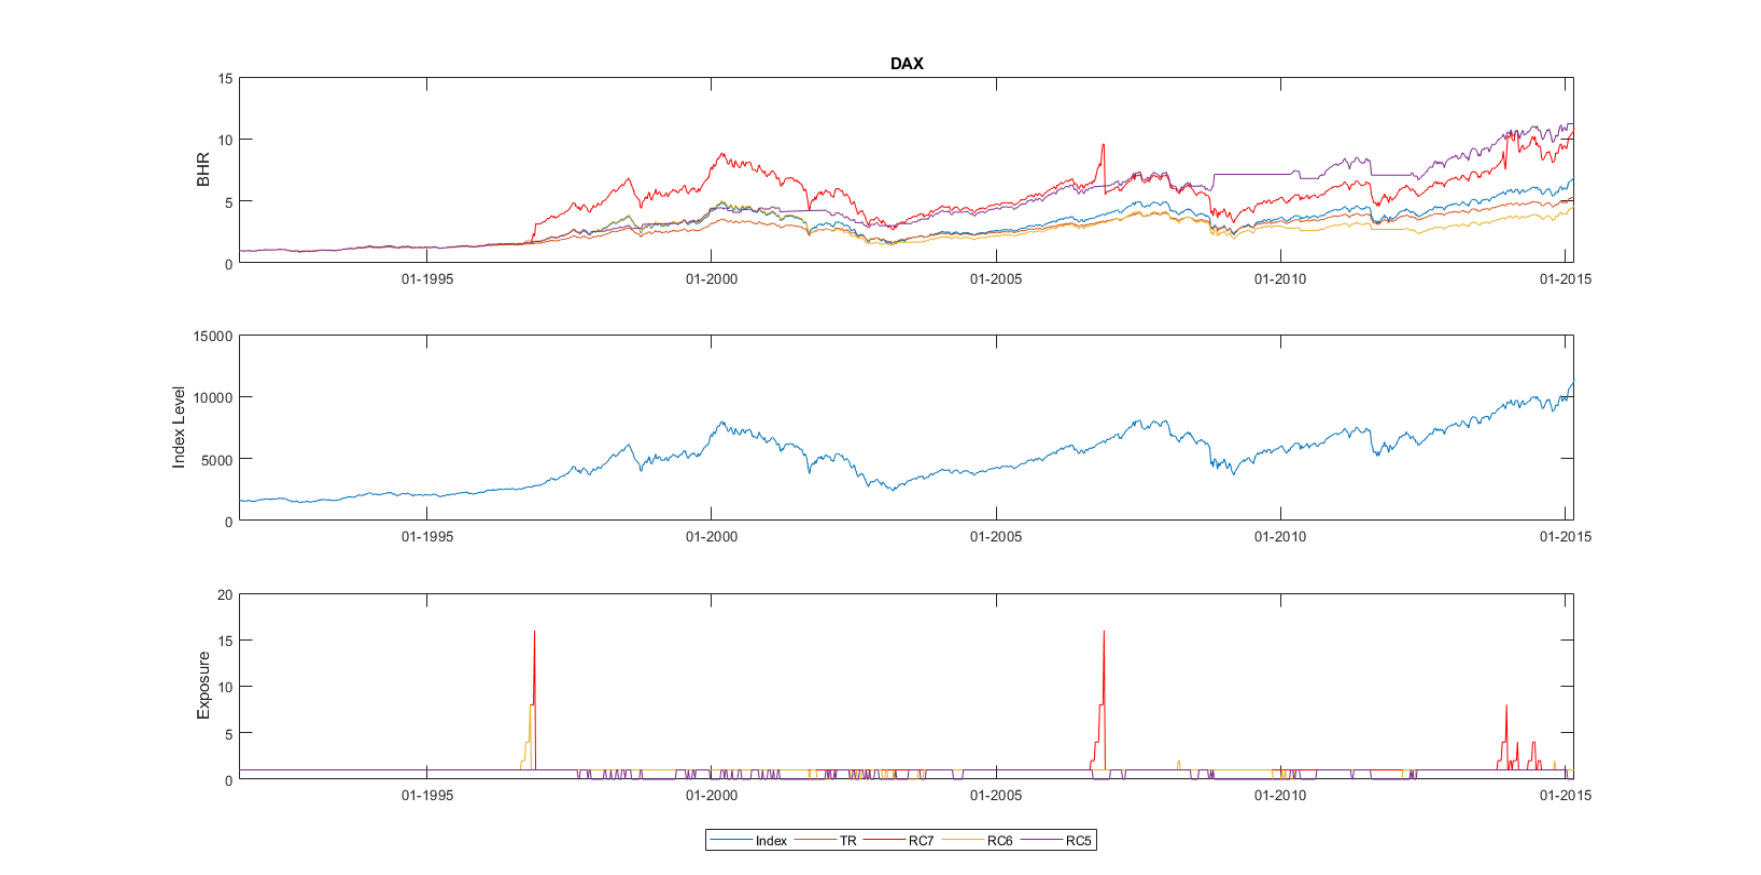
Figure 4. This figure displays the Buy and Hold returns (BHRs) of the volatility-based strategies, the index level and the exposures induced by the trading